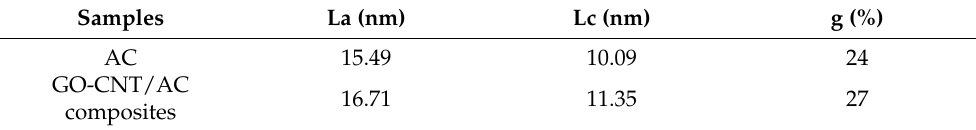
Table 1. Average crystallite size and graphitization degree of AC and GO-CNT/AC composites.